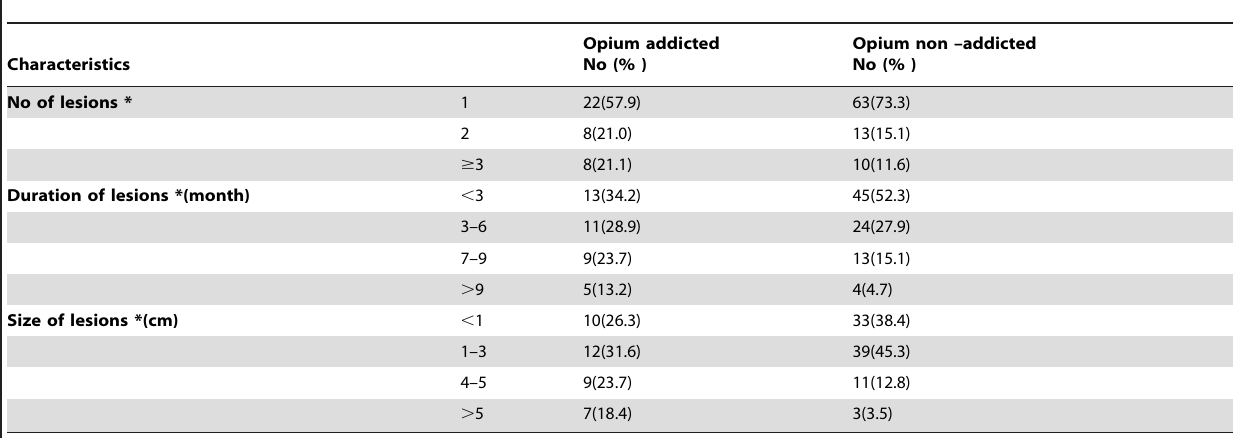
Table 4. The Severity of cutaneous leishmaniasis cases in opium addicted and non –addicted cohorts in terms of the number, duration and size of the